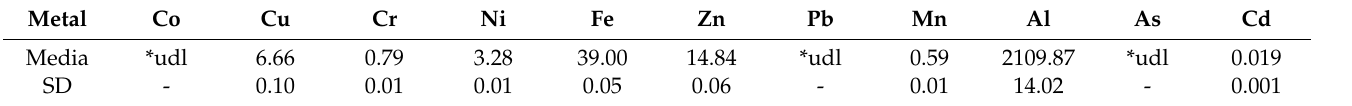
Table 5. Final concentration of metals ( µ g/g), as mean of three